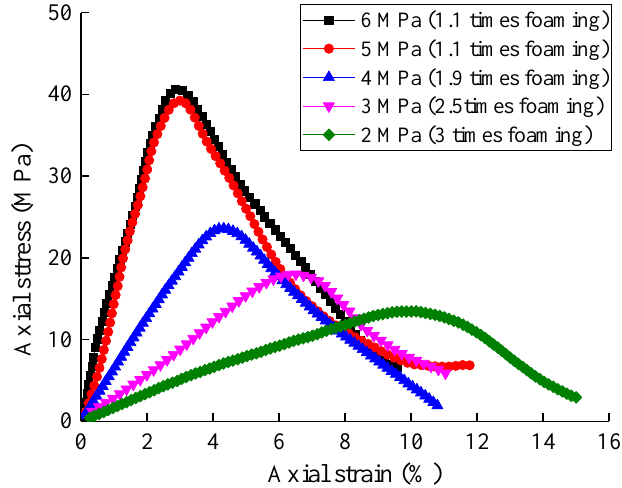
Figure 4. Influence of the grouting pressure on the material strength.